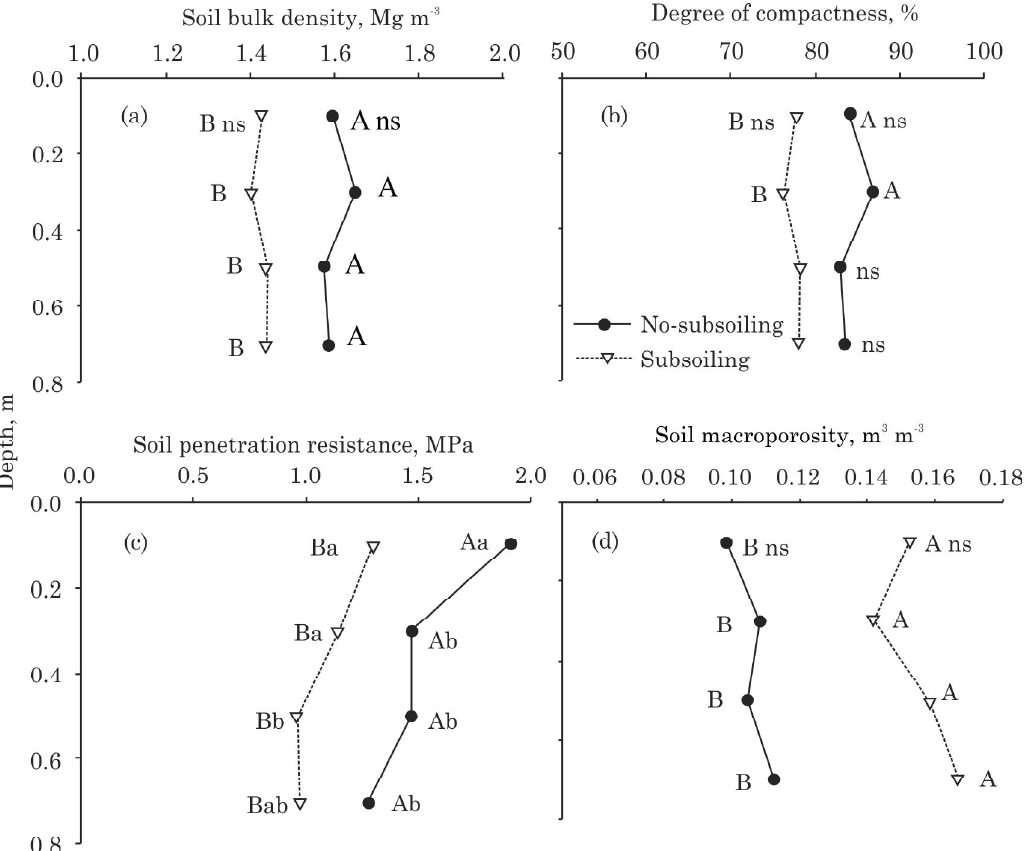
Figure 2. Soil physical properties in the treatments no-subsoiling and subsoiling, applied in a citrus orchard. Capital letters indicate differences between treatments and small letters, differences between depths; ns indicates no significance, based on the Tukey test